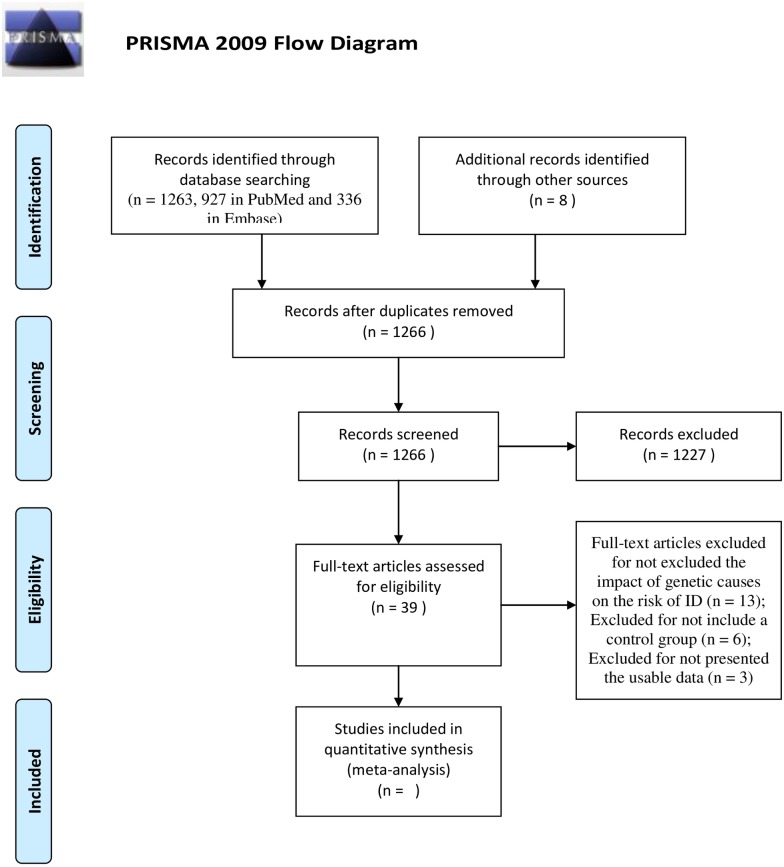
Flow gram of study selection process.